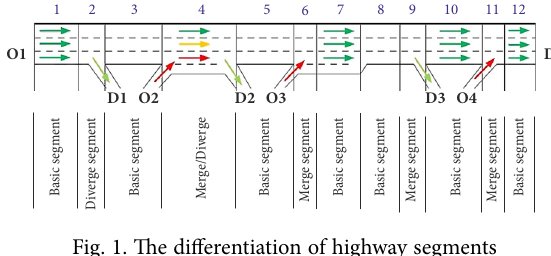
Fig. 1. The differentiation of highway segments (Highway Capacity Manual 2010) Table 1. Recommended boundary values of traffic flow